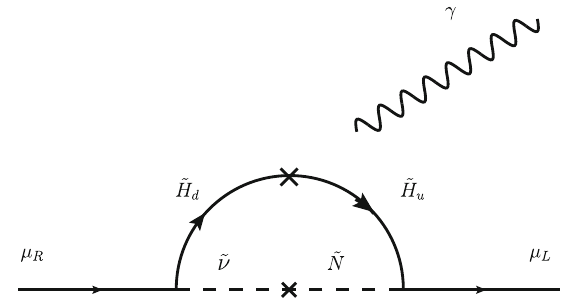
Fig. 3 The new enhancement mechanism contributing to the anoma- lous magnetic moment of the muon in the NMSSM-nuSS